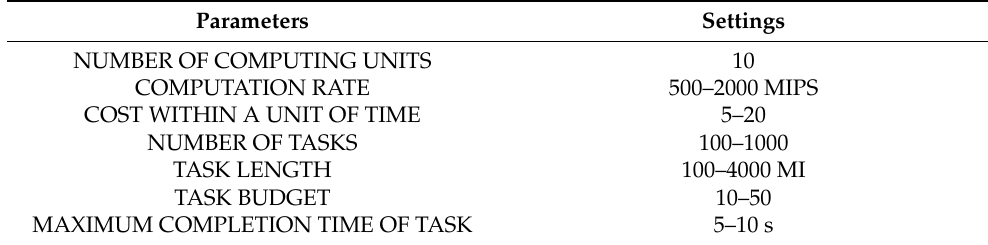
Table 2. Experimental Environment Parameters.